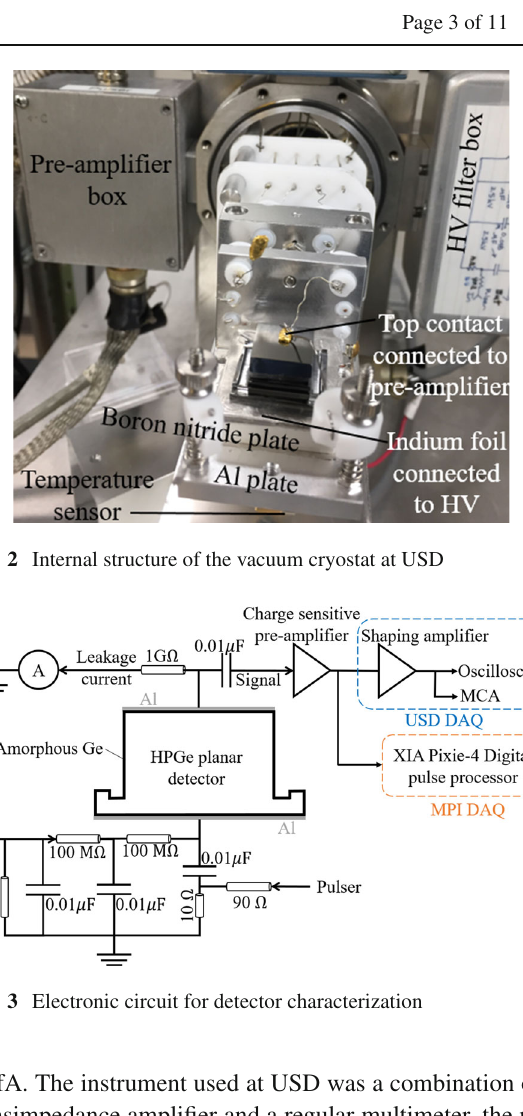
20 fA. The instrument used at USD was a combination of a transimpedance amplifier and a regular multimeter, the pre- cision of which was only 1 pA. The instruments had built- in noise-cancelling mechanisms. The displayed values were averages of a certain number of internal measurements. The leakage currents of the detectors in different environments at 1200 V are summarized in Table